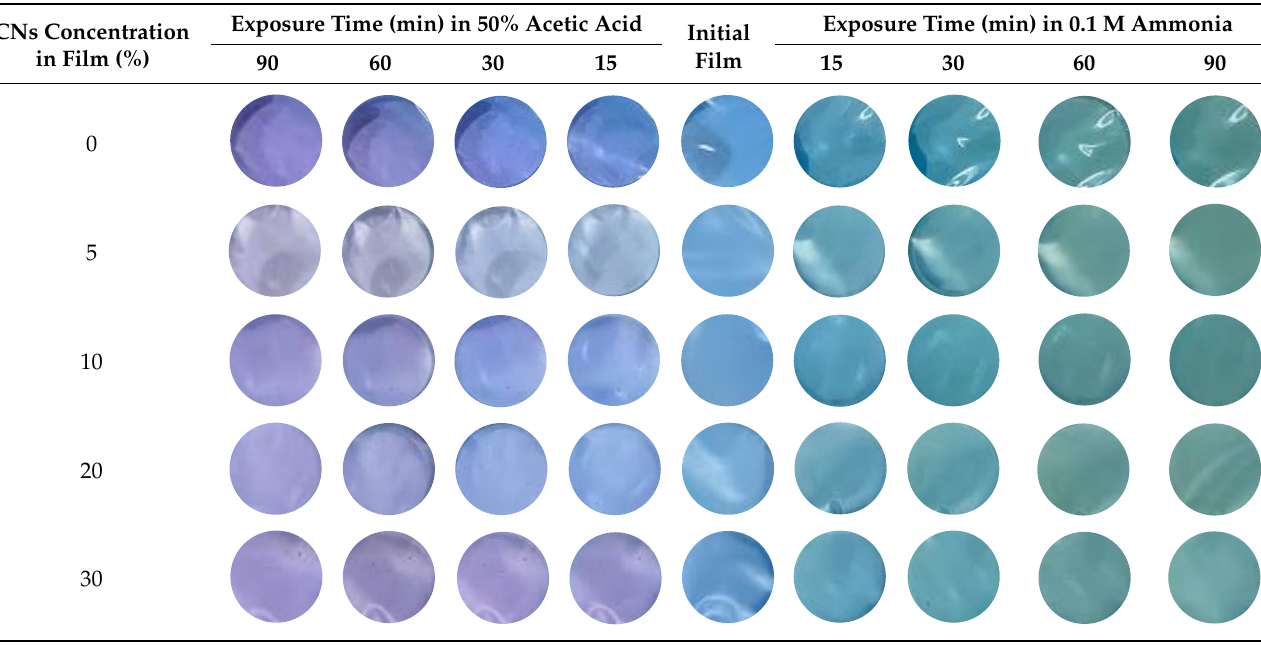
Table 5. Response to volatile ammonia and acetic acid of smart bilayer films incorporating different concentrations of cellulose nanosphere (CNs).